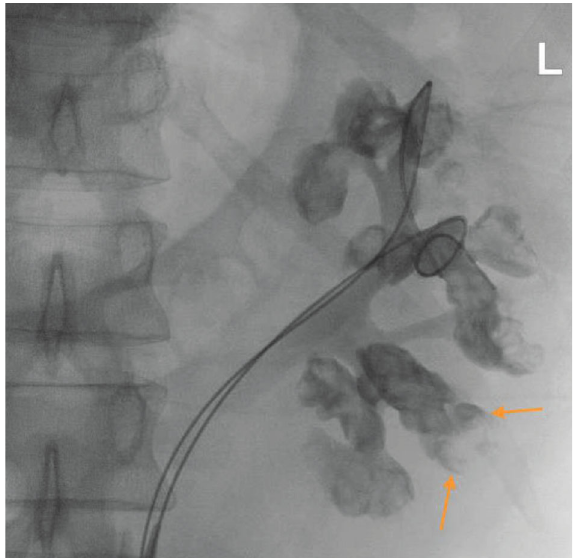
Figure 1: Left retrograde pyelography showing multiple fi lling defects in almost all caliceal ends. Arrows demonstrate the lobster claw sign as the characteristic radiology feature of renal papillary